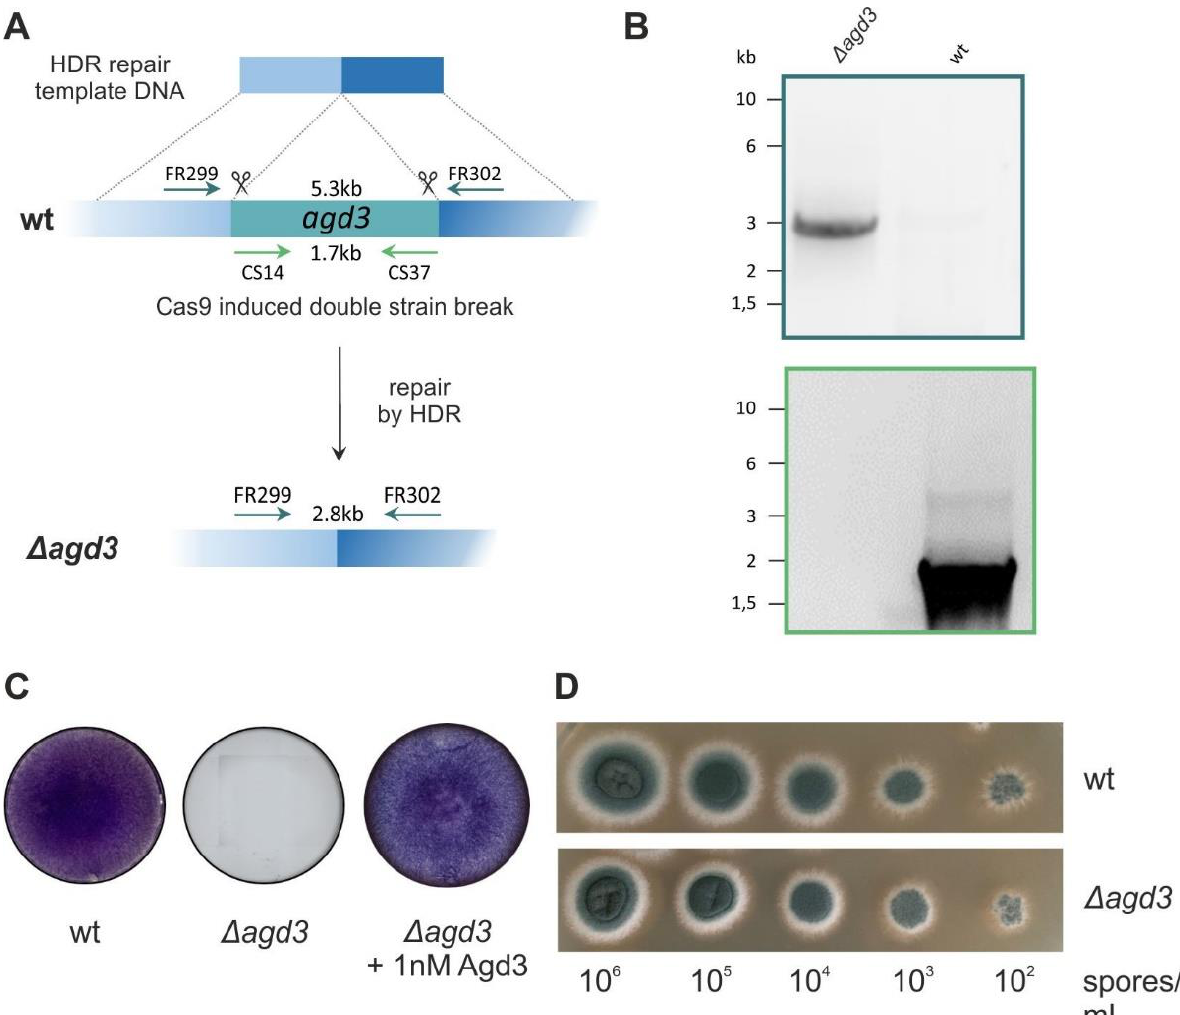
Figure 1. Deletion of agd3 in A. fumigatus S35 strain. ( A ) Scheme of homologous directed repair strategy used for agd3 excision. ( B ) Validation of gene deletion by PCR reactions. The fragment of 2.8kb obtained with primers FR299 and FR302 and absence of agd3 gene amplification with primers CS14 and CS37 confirm gene deletion. ( C ) The 34 h old biofilms were visualized by crystal violet staining. Formation of an adherent biofilm was not observed in the Δ agd3 strain compared to wt ( Af S35) but was restored with the addition of 1 nM purified Agd3 to the growth medium. ( D ) Growth of Δ agd3 and parental AfS35 strain (wt) was analyzed in a drop dilution assay (10 6 to 10 2 spores) on AMM agar plate at 37 °C for 20 h.